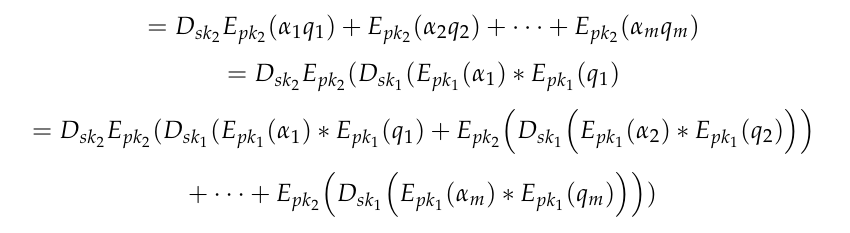
( b ) perfect complements curve Figure 5. Indifference curve.